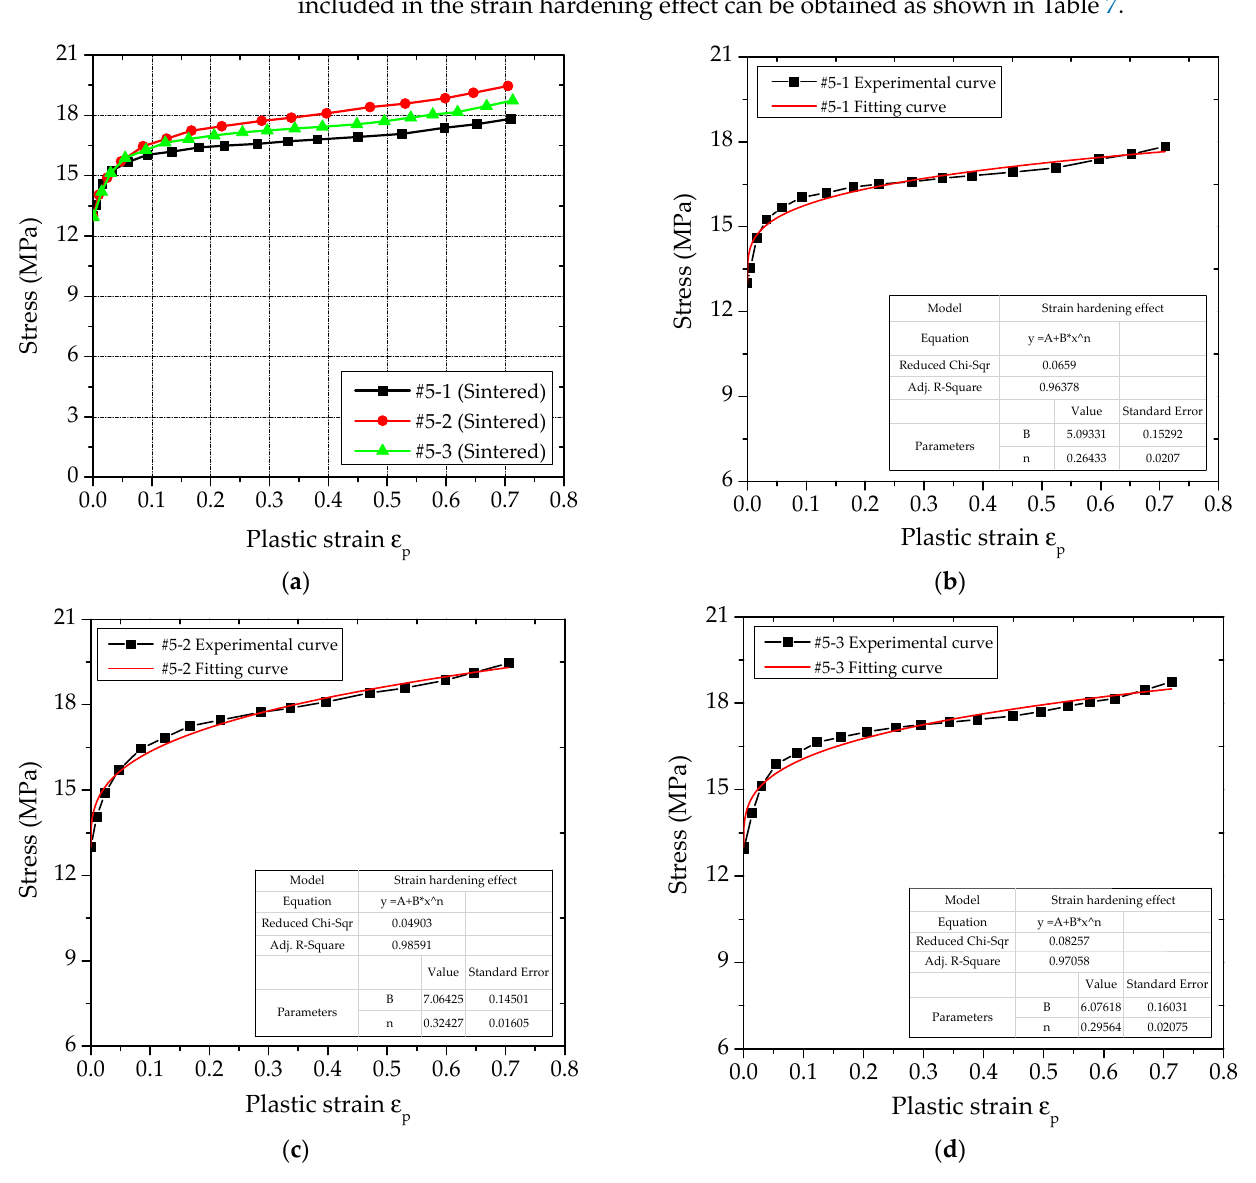
Figure 16. Stress − strain curve and fitting curve of plastic section of PTFE/Al/Si specimen: ( a ) Stress − strain curve of plastic section of PTFE/Al/Si specimen; ( b ) Fitting curve corresponding to # 5-1 working condition; ( c ) Fitting curve corresponding to # 5-2 working condition; ( d ) Fitting curve corresponding to # 5-3 working condition. Table 7. Fitting parameters of the strain hardening